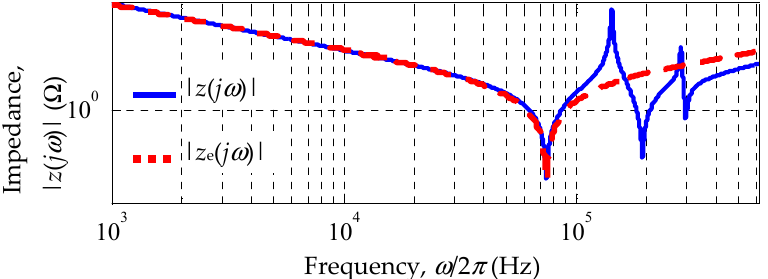
Figure 7. Comparison of the amplitude frequency characteristics of the equivalent and full equivalent circuits of a solar panel.